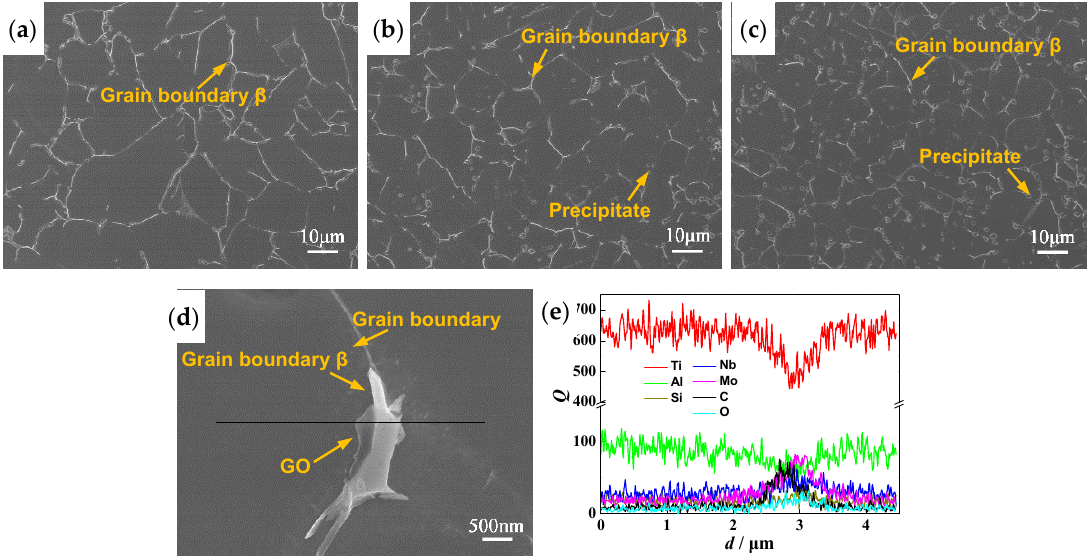
Figure 8. SEM images of the composites with different addition amounts of GO; ( a ) 0; ( b ) 0.3 wt%; ( c ) 0.5 wt%; ( d ) Transparent GO sheet in the composite added with 0.3 wt% GO ( e ) EDS line scanning of the linear area in Figure 8d.